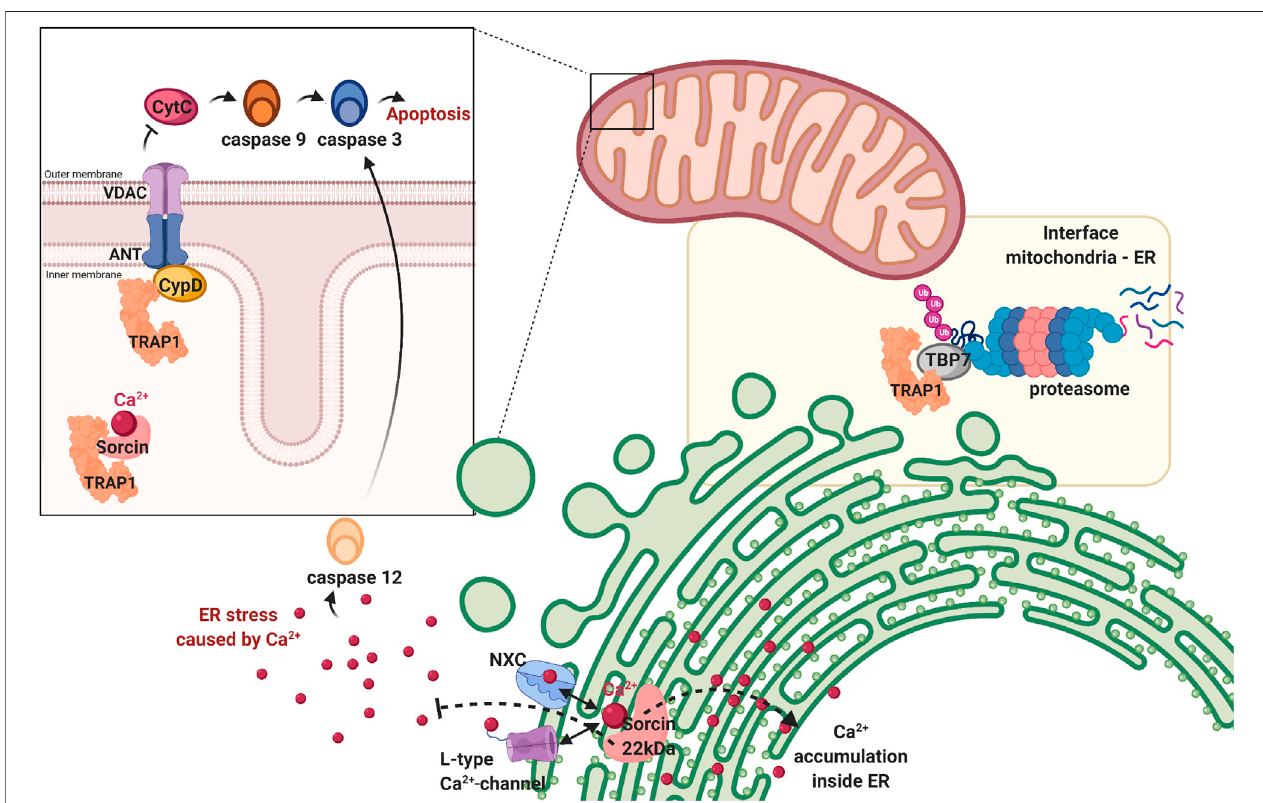
FIGURE5| TRAP1isinvolvedinmaintainingcellularhomeostasis.First,TRAP1regulatesmitochondrialhomeostasisbypreventingthepermeabilitytransitionpore formed by VDAC and ANT from opening by antagonising cyclophilin D (CypD). When this pore is opened, Cytochrome C (CytC) is released in the cytosol, activating the caspase cascade resulting in apoptosis. Second, TRAP1 is also found on the interface of the mitocohondria and endoplasmic reticulum, associating with tat-binding protein7(TBP7),asubunitoftheproteasome.Ithelpsregulatingproteinhomeostasisbeforetheyenterthemitochondria,repairingifpossibleordegradingproteins if damaged beyond repair. Third, the dual location of the sorcin-isoforms suggests TRAP1 to have a role in calcium regulation (represented as red dots). Sorcin is a calcium sensor, which can regulate Na + /Ca 2+ channel (NXC) and L-type Ca 2+ channel on the endoplasmic reticulum, maintaining calcium homeostasis within the organelle and preventing cellular stress resulting from cytosolic calcium. Sorcin is a TRAP1 client and is thought to have a similar role in the mitochondria. Figure made with